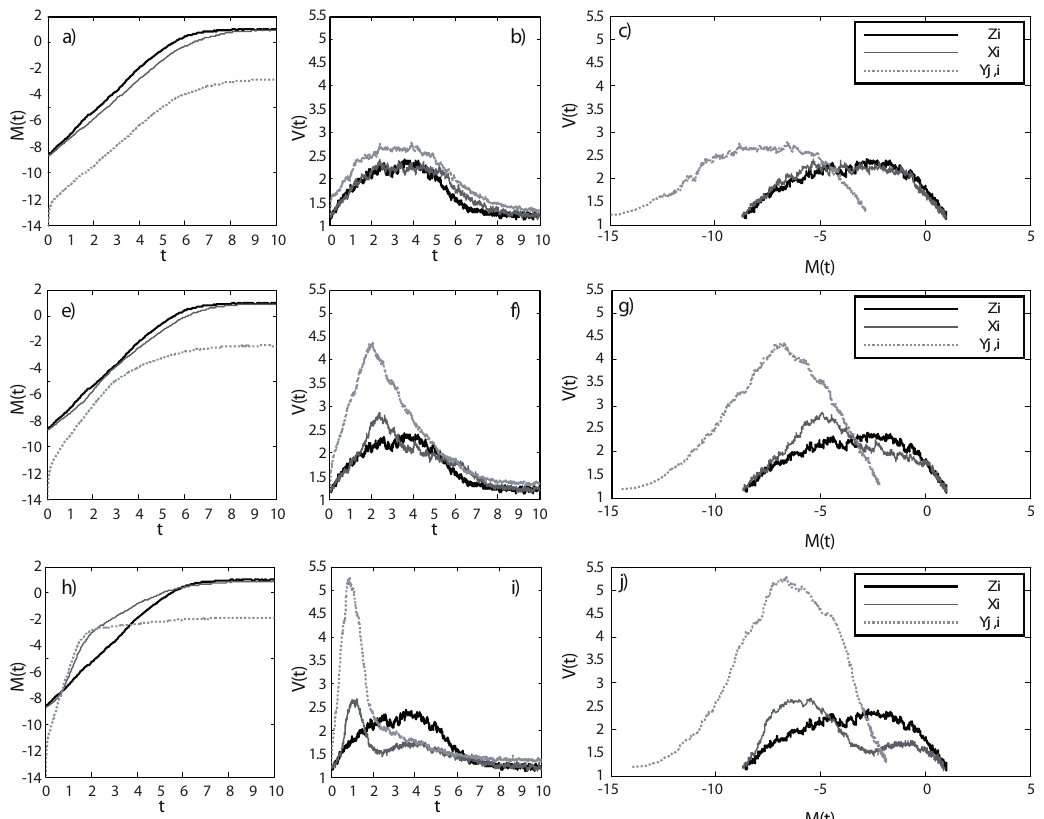
Fig. 6. Time series of the mean (a, e, h) and variance (b, f, i) of the log-perturbations of a simplified L96 model (black) and the slow ( x i , dark gray) and fast ( y j,i , light gray) components of a two-scale L96 model. (c, g, j) MVL diagrams corresponding to the previous components. The upper row (a, b, c) is for weak coupling h =0.26, the medium row (e, f, g) is for medium coupling h =0.6 and the lower row is for strong coupling h =1. All curves are averages of 200 realizations (see